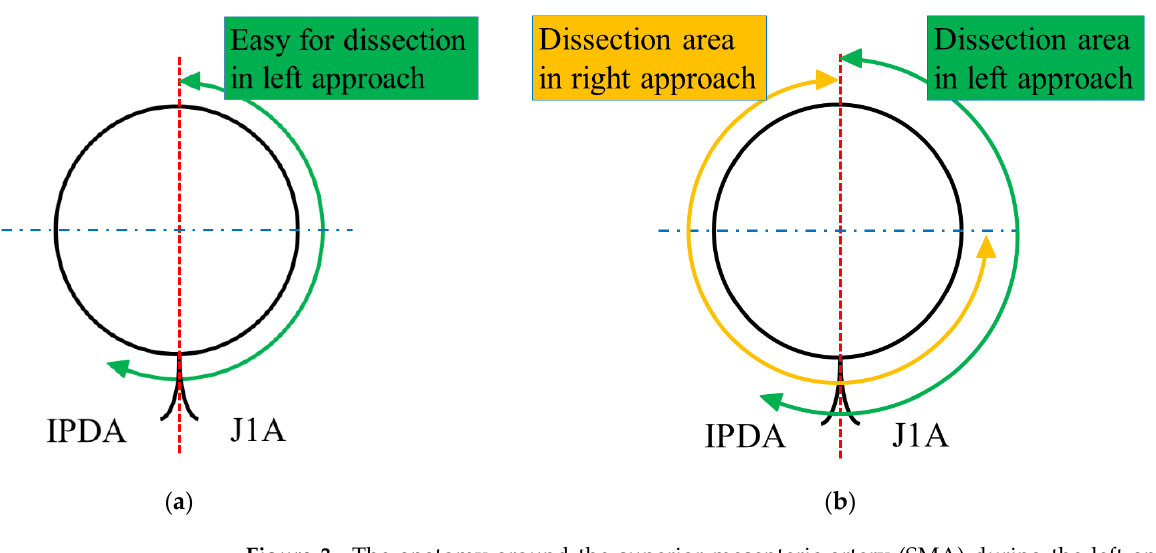
Figure 3. The anatomy around the superior mesenteric artery (SMA) during the left and right approaches: ( a ) the left approach is suitable for dissecting the left aspect of the SMA; and ( b ) the overview of circumferential dissection around the SMA using a combination of both approaches. IPDA, inferior pancreaticoduodenal artery; J1A, first jejunal artery.